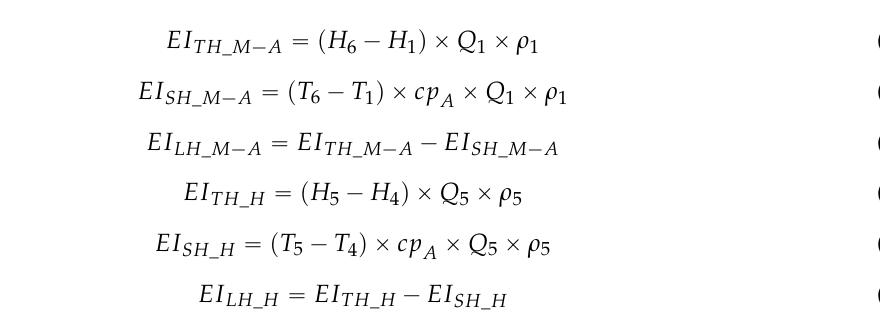
Figure 6. Energy increments for ( a ) Case A1; ( b ) Case A2; ( c ) Case B1; ( d ) Case B2; ( e ) Case C1; and ( f ) Case C2. TH = total heat; LH = latent heat; SH = sensible heat; RT = regeneration temperature.